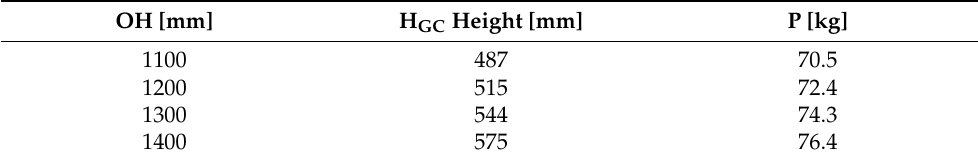
Table 2. Examples of FROPS weights extracted from